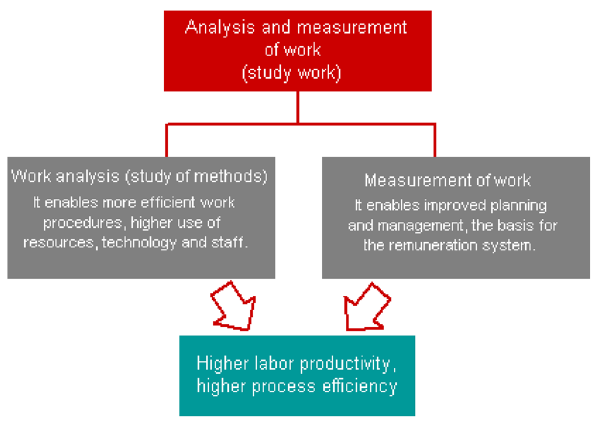
Figure 1: Scheme of analysis and measurement of work.